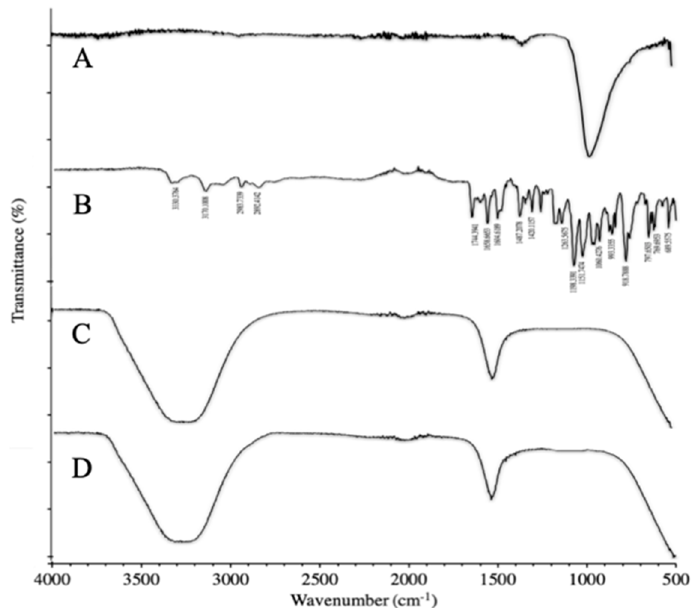
Figure 6. FTIR analysis of synthesized PEGylated chitosan. ( A ) TPP. ( B ) TAF. ( C ) Deprotected PEGylated chitosan nanoparticles. ( D ) TAF-loaded PEGylated chitosan nanoparticles.